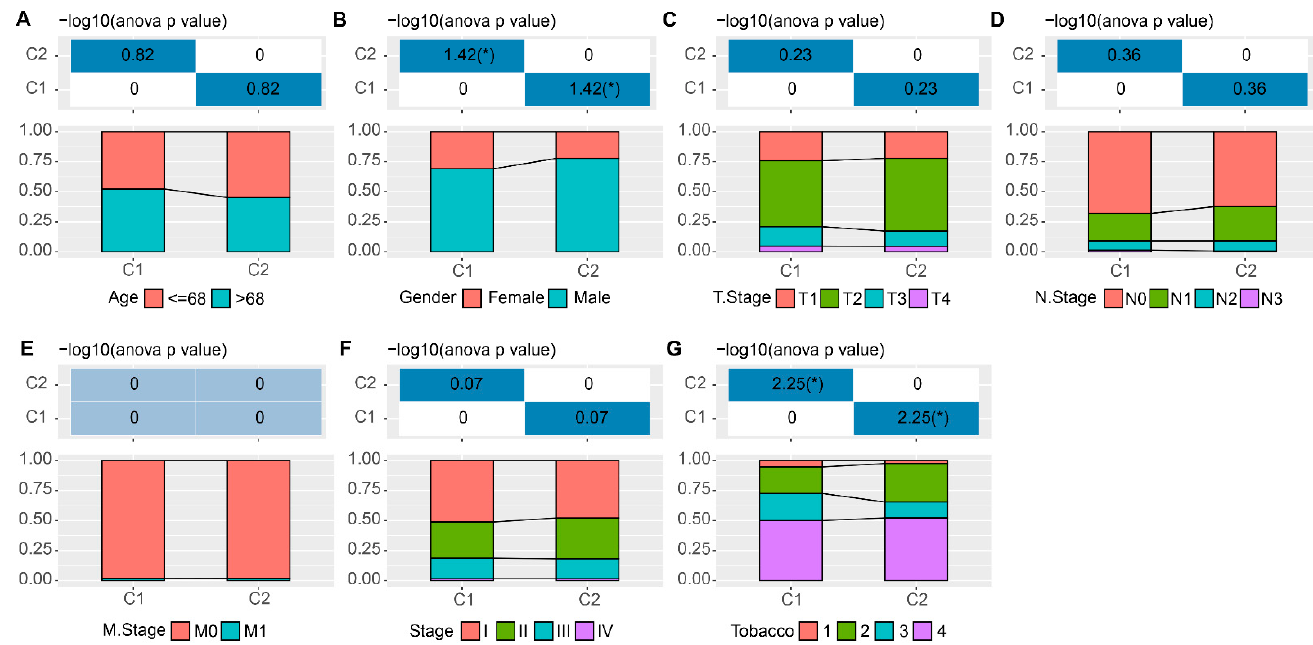
Figure 2. Clinical information distribution of molecular subtypes in the TCGA cohort. The chi-square test of the clinical information distribution of different molecular subtypes: including age ( A ), T-Stage ( B ), N-Stage ( C ), M-Stage ( D ), stage ( E ), gender ( F ) and tobacco ( G ). Tobacco lifelong non-smoker (less than 100 cigarettes smoked in lifetime) = 1; Current smoker (includes daily smokers and non-daily smokers or occasional smokers) = 2; Current reformed smoker for > 15 years (greater than 15 years) = 3; Current reformed smoker for ≤ 15 years (less than or equal to 15 years) = 4. * 0.01 ≤ p < 0.05.